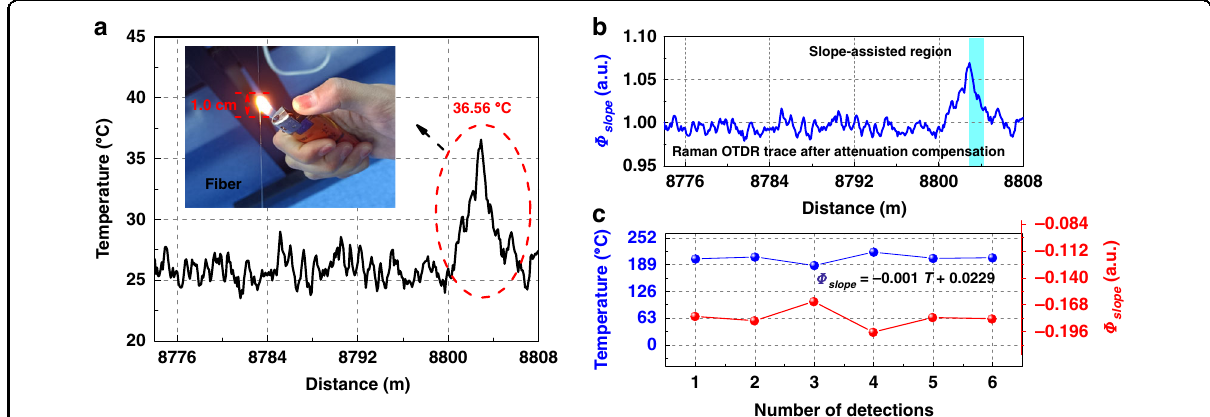
Fig. 8 Temperature measurement results at a centimeter-level spatial scale detected using a conventional demodulation method and slope-assisted demodulation method. a Results measured using the conventional demodulation method, ( b ) distribution of superimposed Raman OTDR trace after attenuation compensation, ( c ) results measured using the slope-assisted coef fi cients. Reprinted with permission from ref. 57 , © 2021 Chinese Laser